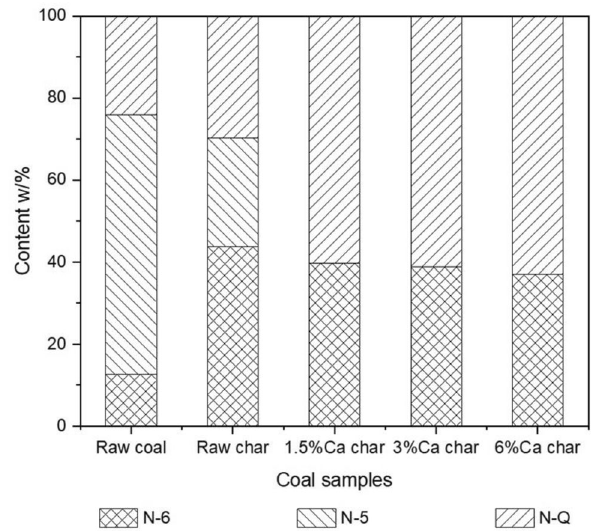
Fig. 7 The distributions of N in chars after pyrolysis of coal and Ca- loaded coal samples at 800 (cid:3)